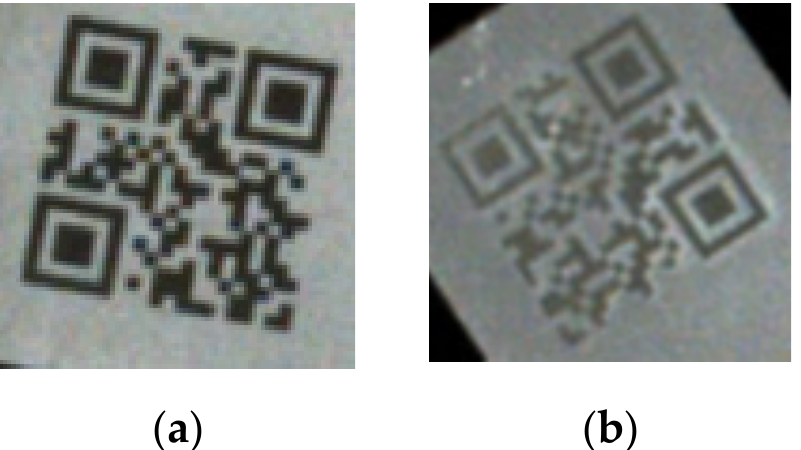
Figure 1. Image of laser-generated QR code: ( a ) image of a normal two-dimensional laser-generated code and ( b ) image of a low-contrast two-dimensional laser-generated code.